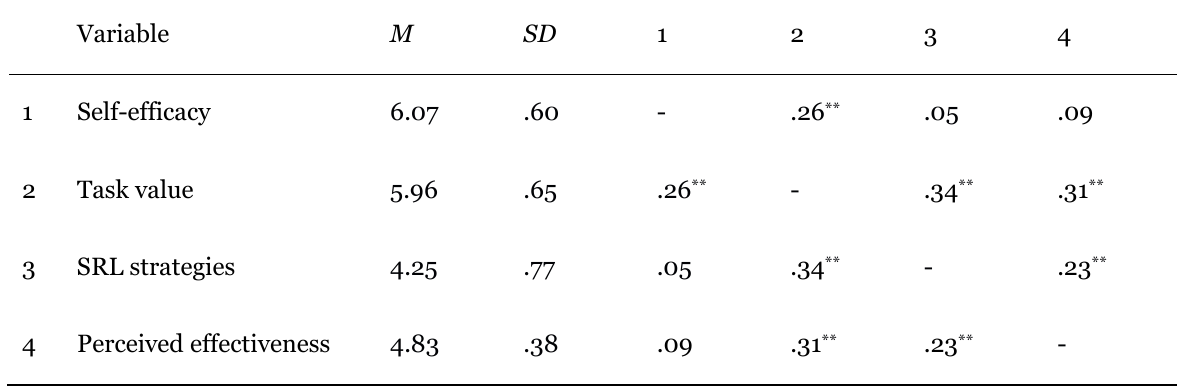
Means, Standard Deviations, and Pearson Correlations for Self-Efficacy, Task Value, SRL Strategies, and Perceived Effectiveness